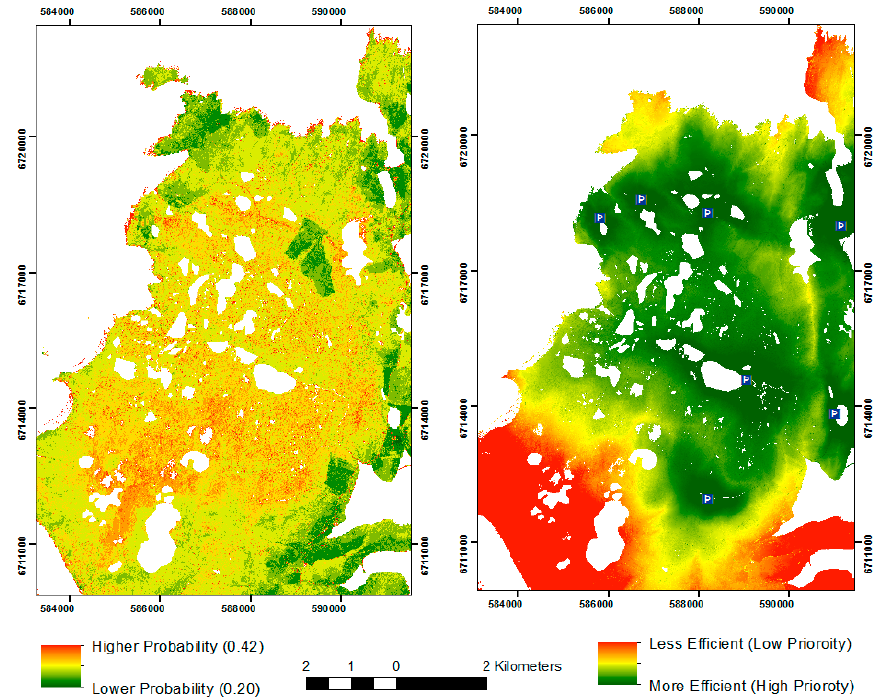
Figure 6. Probability Model 9 and Hybrid surface using Cost-Surface.